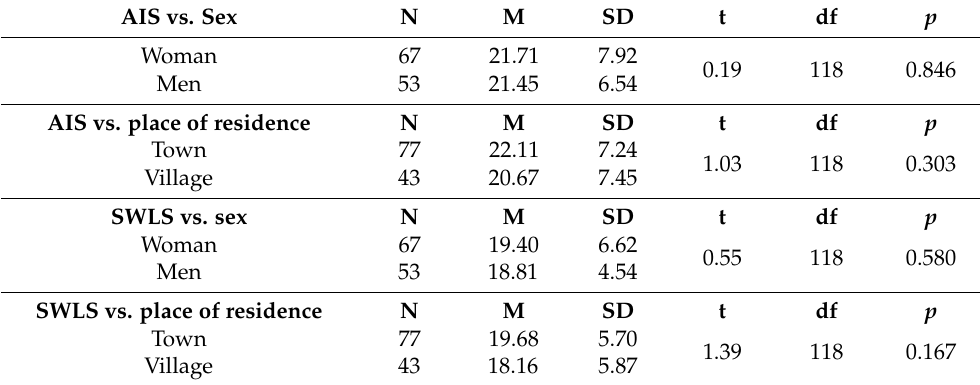
Table 8. Acceptance of illness and satisfaction with life versus sex and place of residence. AIS vs. Sex N